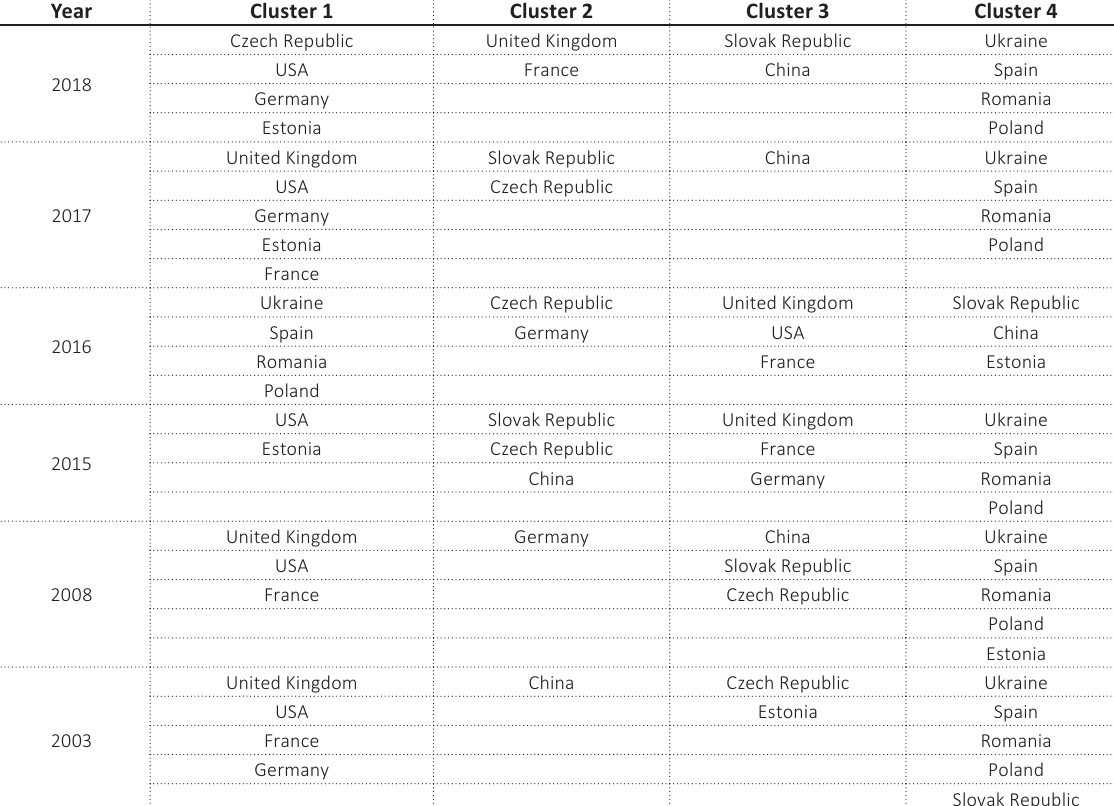
Table 5. Grouping of the countries according to their level of technology using